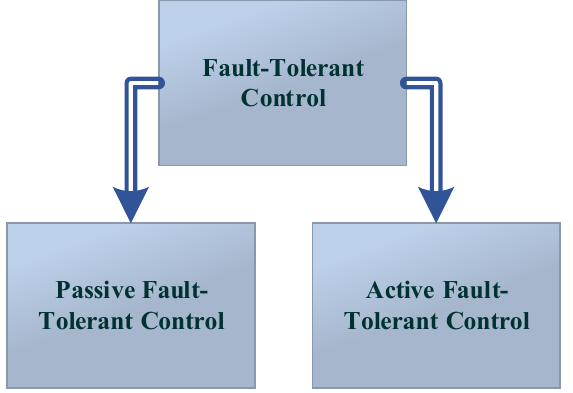
Figure 1. The fault-tolerant control types.